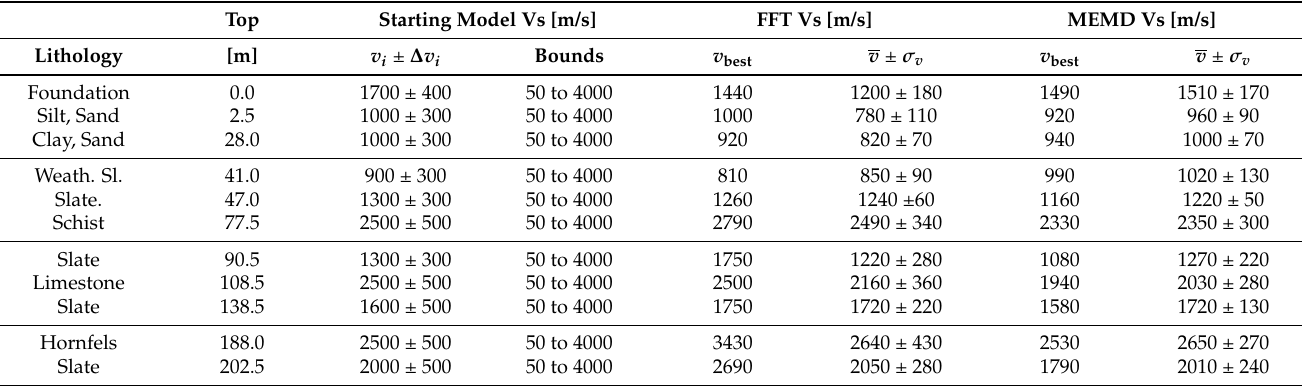
Table 1. Well-log lithology and HVSR inversion initial and final Vs models from the ICJA station are summarized. 350 initial models were generated randomly in the range v i ± ∆ v i . During the inversion, model parameters had to remain within the given bounds. Best model, v best , and mean model with standard deviation, v ± σ v , resulted from the inversion of data processed by the two different algorithms, FFT and